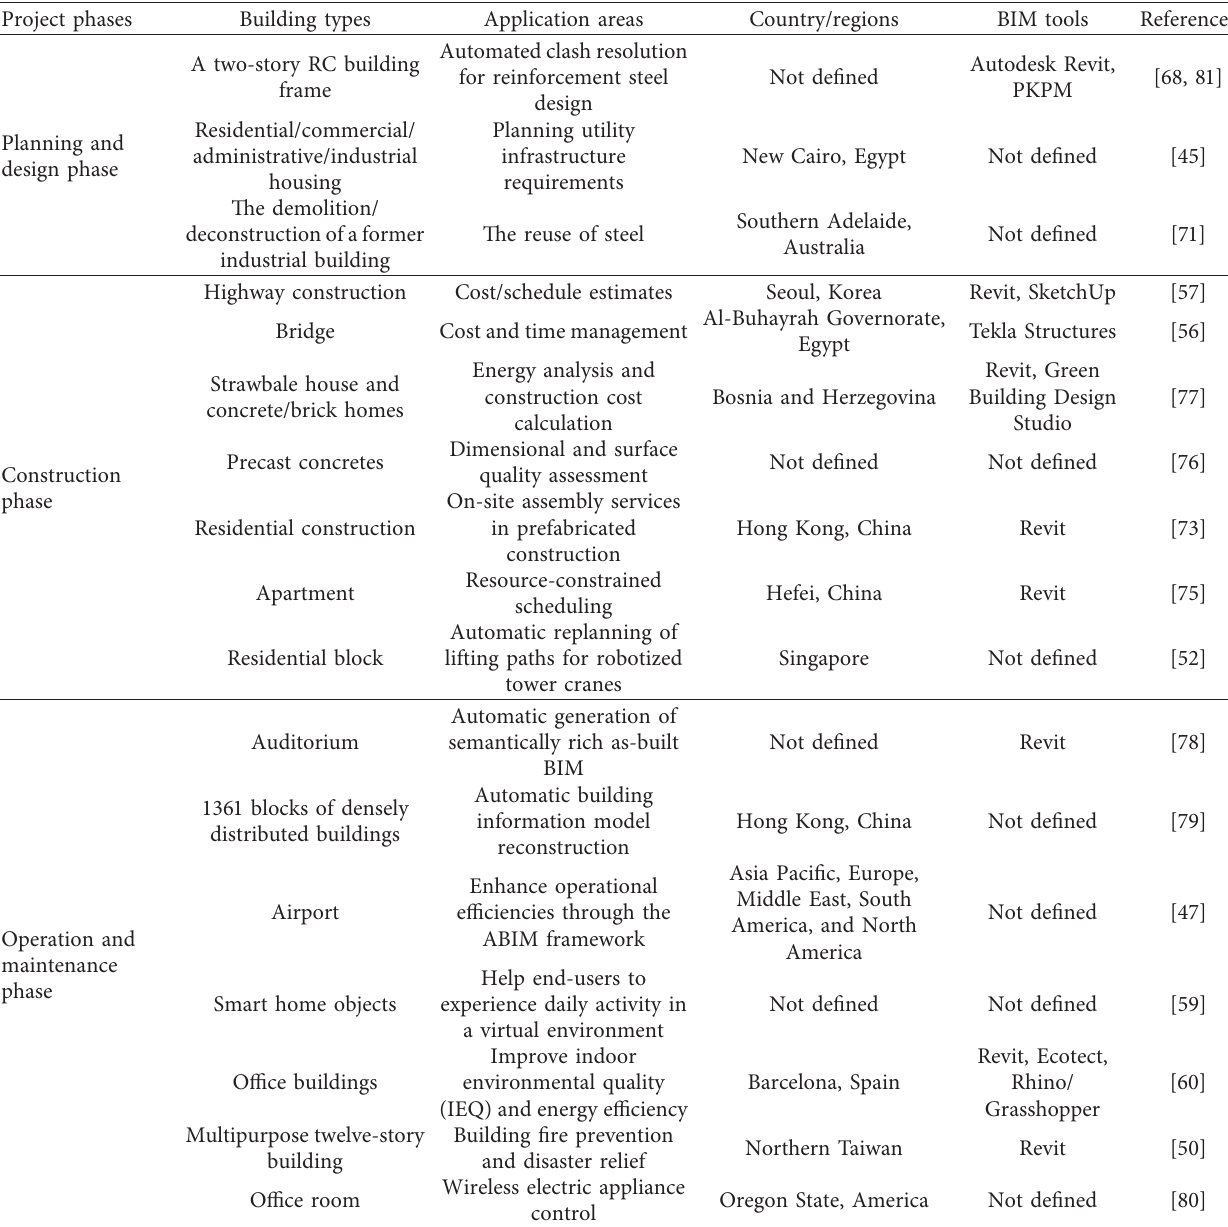
Table 4: Review cases of BIM-based smart buildings in the building life